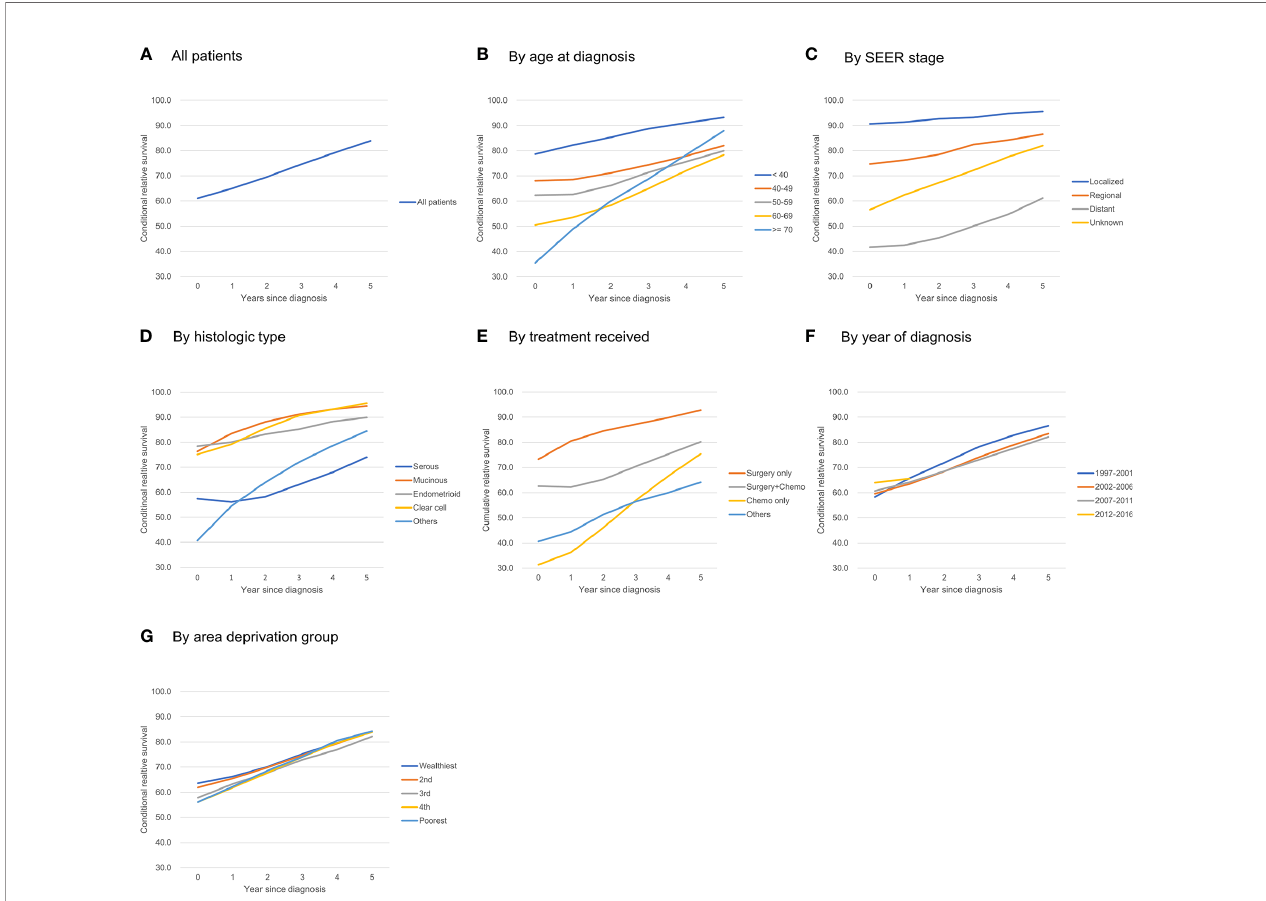
FIGURE 1 | Five-year conditional relative survival of ovarian cancer patients. (A) all patients; (B) by age at diagnosis; (C) by SEER stage; (D) by histologic type; (E) by treatment received; (F) by year of diagnosis; (G) by area deprivation